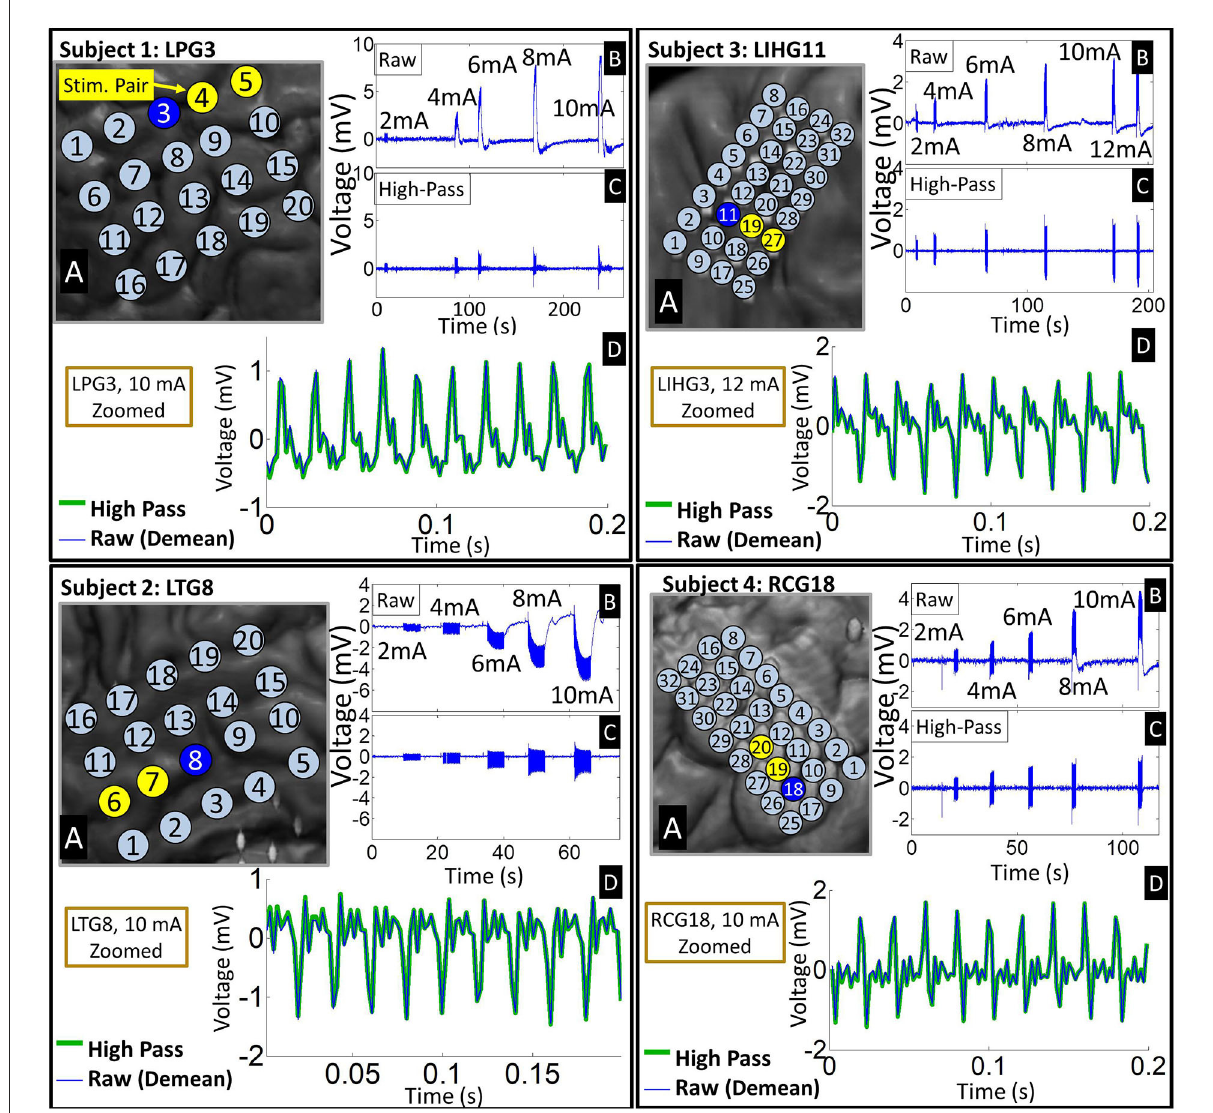
FIGURE2 Representative examples of time-domain signal features across four subjects. (A) Insets of co-registered images showing the representative grid with the stimulation channel marked in yellow. (B) Time-domain signals from an electrode (marked by blue on the grid) adjacent to the stimulation channel exhibiting ratcheting effects. The raw waveforms show 5–6 stimulation epochs at different stimulation amplitudes. Note that ratcheting severity increases with stimulation amplitude. (C) The ratcheting is removed by high-pass filtering at 1.5 Hz. (D) A zoomed plot